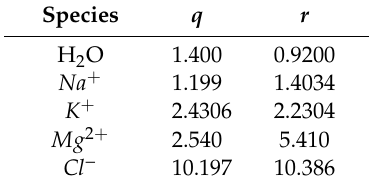
Table 2. Parameters q and r of typical species in UNIQUAC